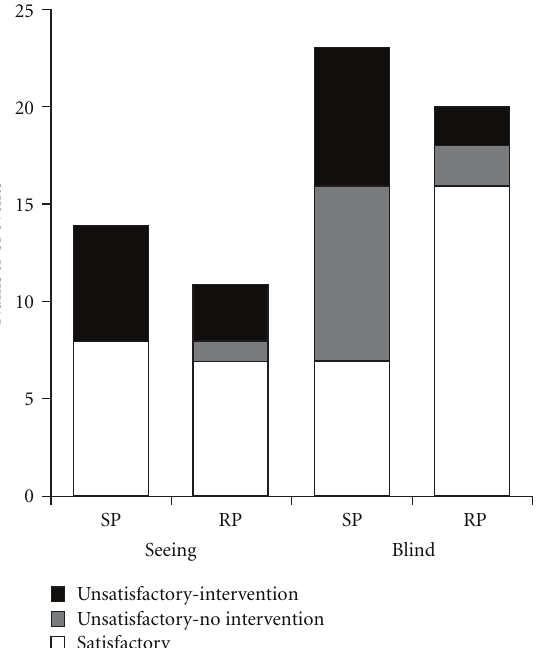
Figure 3: Number (median and interquartile range) of interven- tions in each drive for individual participants. Noncurrent drivers had fewer interventions in the real prism (RP) than the sham prism (SP) drives, and more interventions than current drivers in the SP but not the RP drives. The thick horizontal line within each box is the median; the vertical extent of the box is the interquartile range (IQR); vertical lines at box ends represent the largest nonoutlier data points within 1.5x IQR. Open triangle is a far outlier ( > 3x IQR).